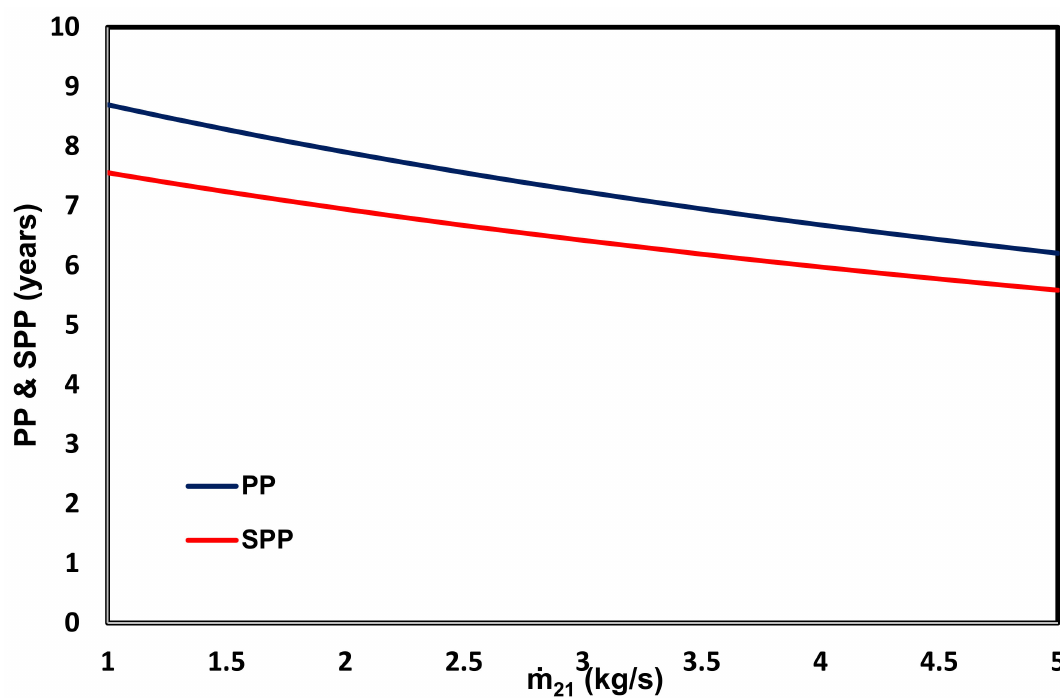
Figure 11. The variation in PP and SPP versus feed seawater mass flow rate.